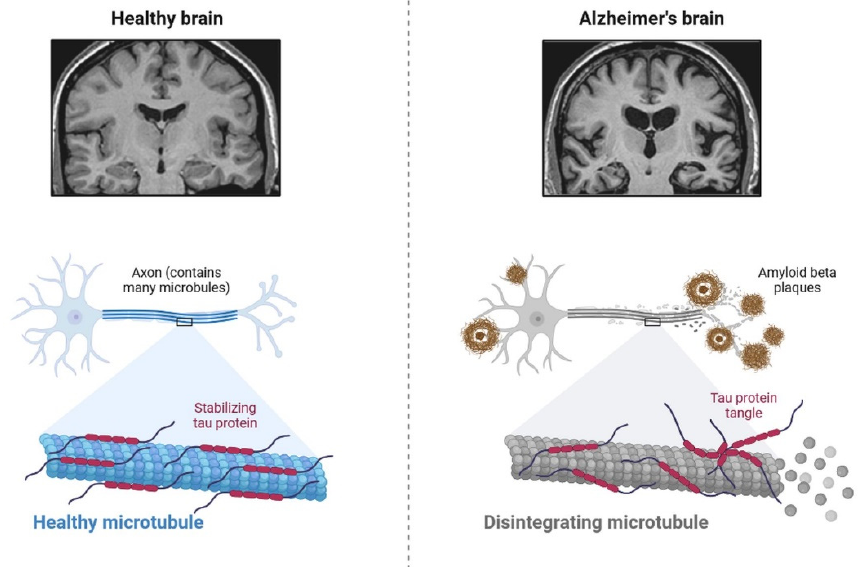
Figure 7. The pathological properties of the Alzheimer’s disease brain (involving tau protein) compared with that of the healthy brain, on various magnification levels. It can be adapted as a component.